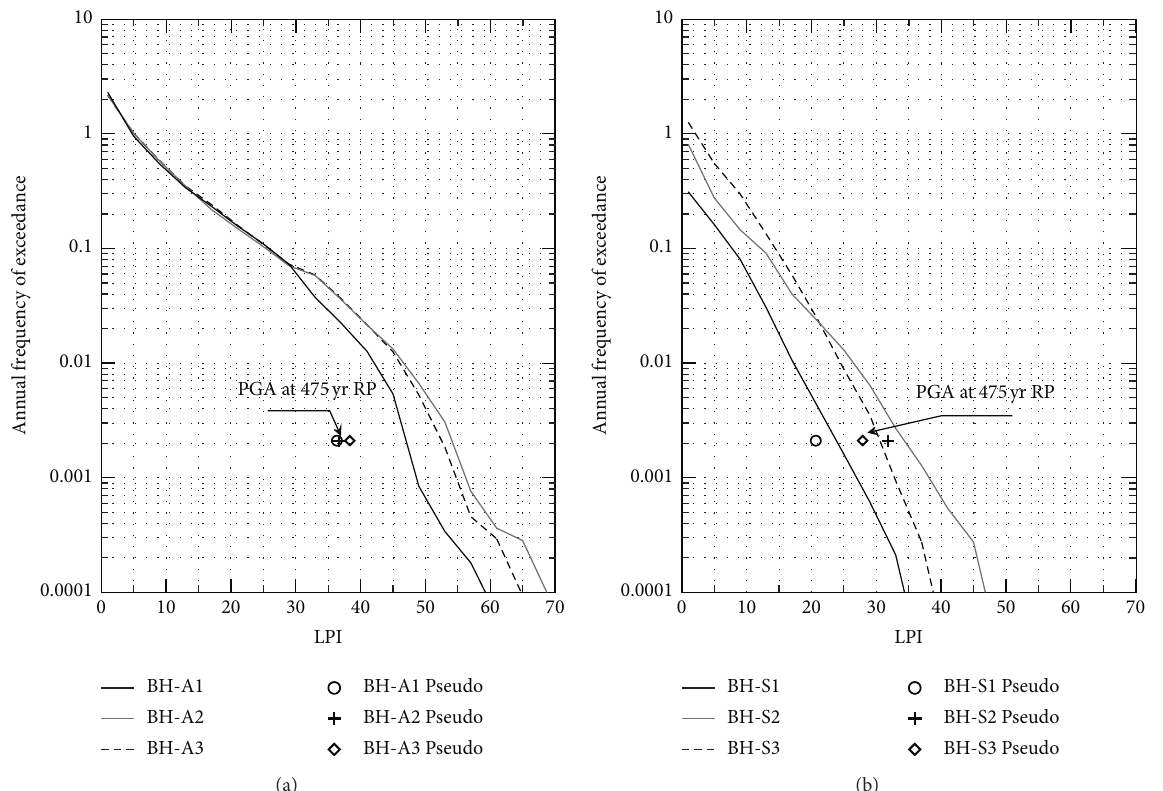
Figure 4: Hazard curves of LPI from the HAZ45PL Module. (a) Annan site and (b) Xinshi site.